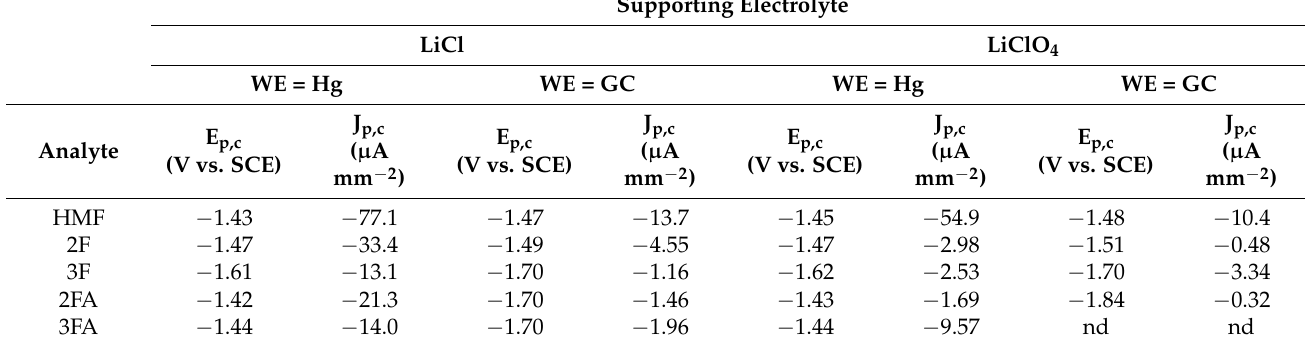
Table 5. Cathodic peak potentials E p,c (V vs. SCE) and cathodic peak current densities J p,c ( µ A mm − 2 ) in the SWV determination of HMF, 2F, 3F, 2FA, and 3FA (concentration: 1 mmol dm − 3 each) by varying the nature of WE (Hg or GC) and that of the supporting electrolyte (LiCl or LiClO 4 , both 0.1 mol dm − 3 in water). Potential scan rate: 0.10 V s − 1 ; cathodic window of potential: between 0 and − 2.0 V vs. SCE; AE: Pt; RE: SCE; pulse height: 4 mV; frequency: 15 Hz; modulation amplitude: 25 mV.